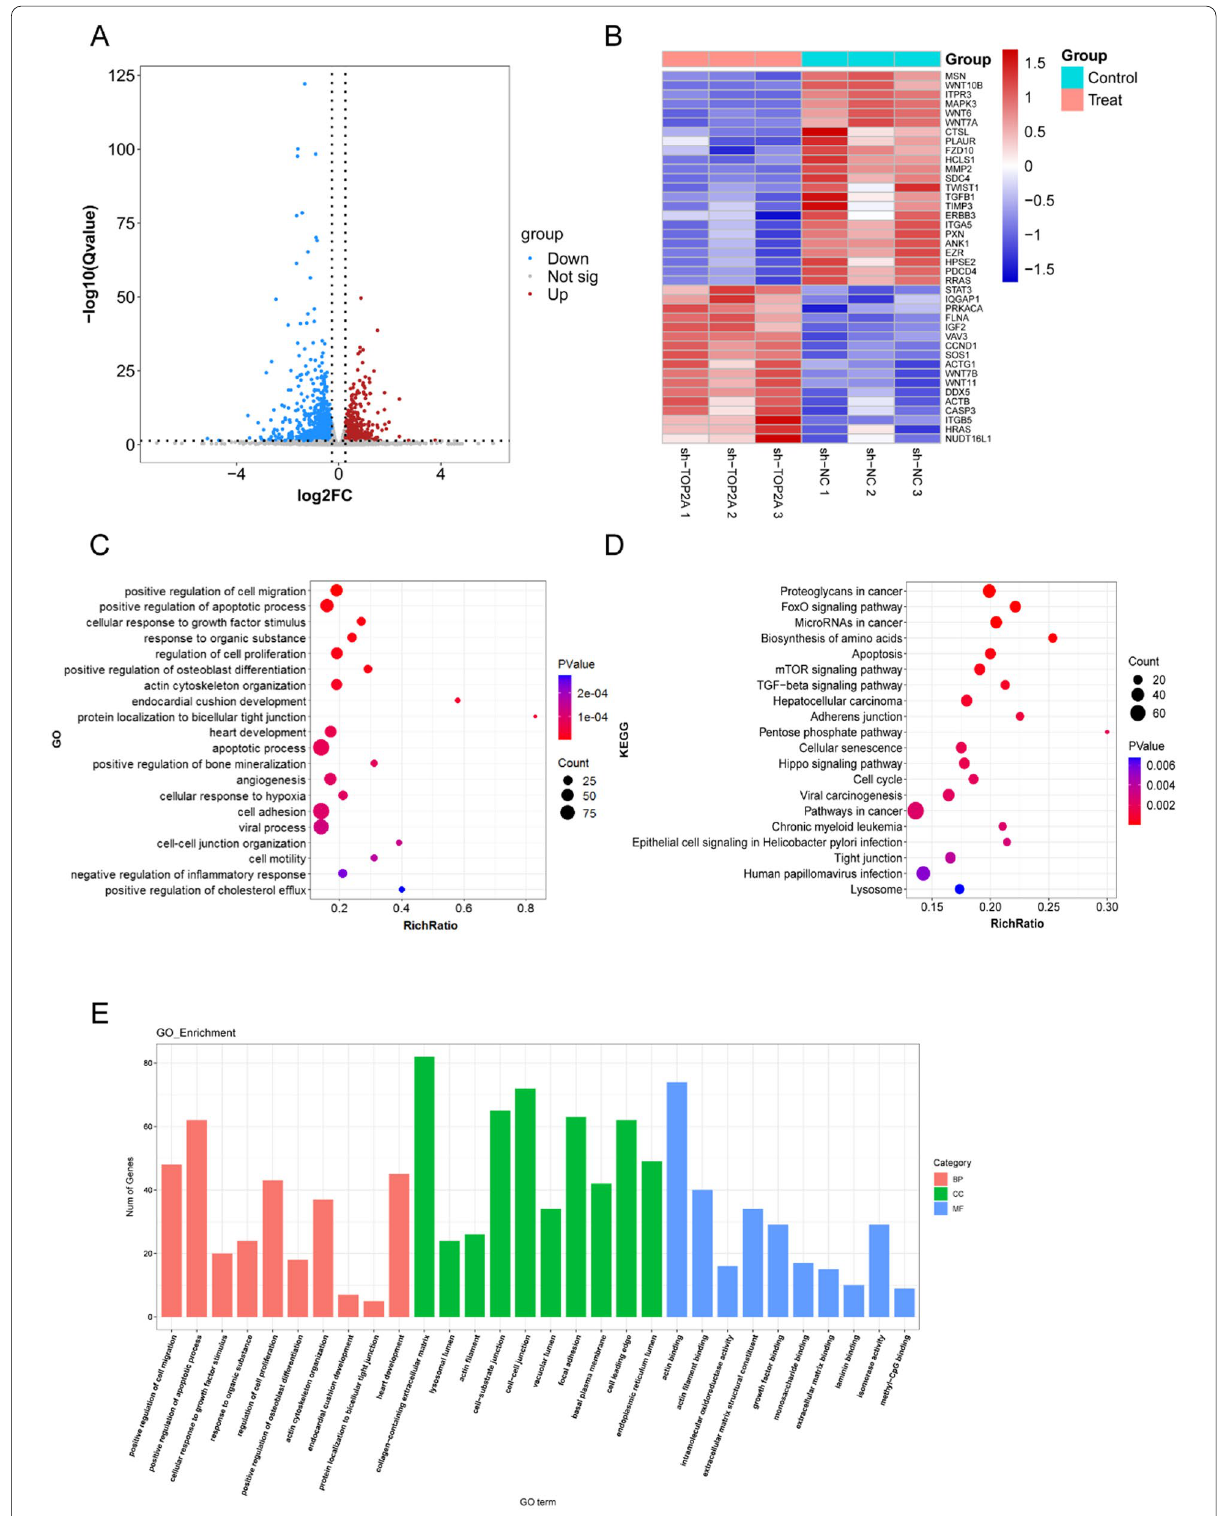
Fig. 5 Regulatory network for TOP2A. A , B Differentially expressed genes after TOP2A knockdown are shown in volcano and heatmap plots. C – E TOP2A-associated downstream paths were illustrated using KEGG and GO enrichment